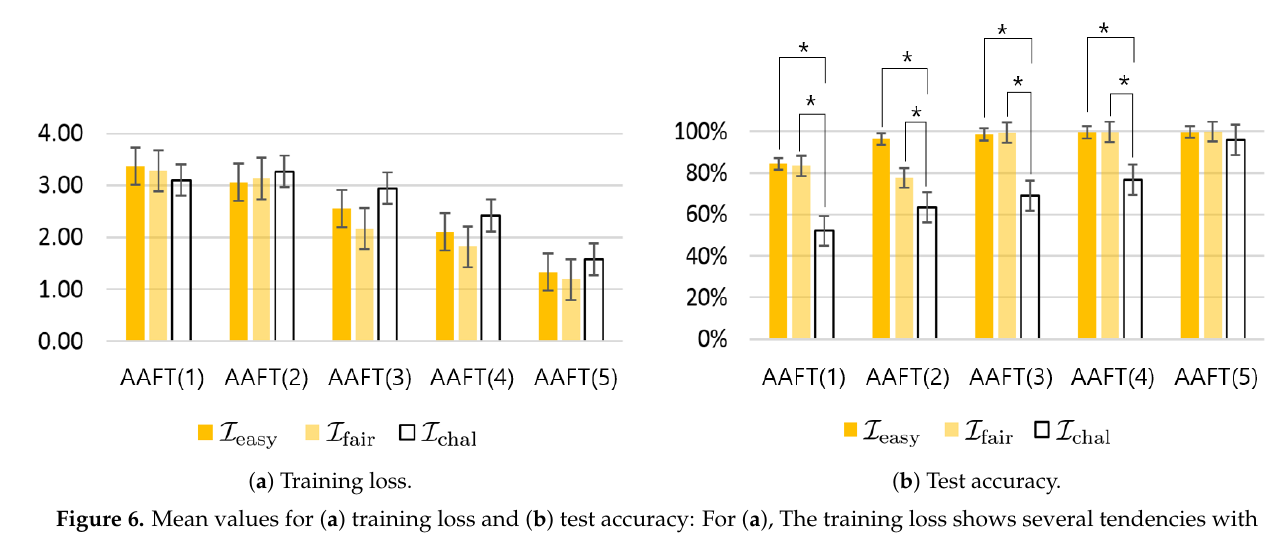
Figure 6. Mean values for ( a ) training loss and ( b ) test accuracy: For ( a ), The training loss shows several tendencies with respect to two factors, but no significant difference found by pairwise comparison. For ( b ), pairwise comparison indeed revealed that the test accuracy of both I easy and I fair was significantly higher than that of I chal upto AAFT(4). No significant difference was found between I easy and I fair across all AAFT levels. Significance is marked for p < 0.05 ( ∗ )